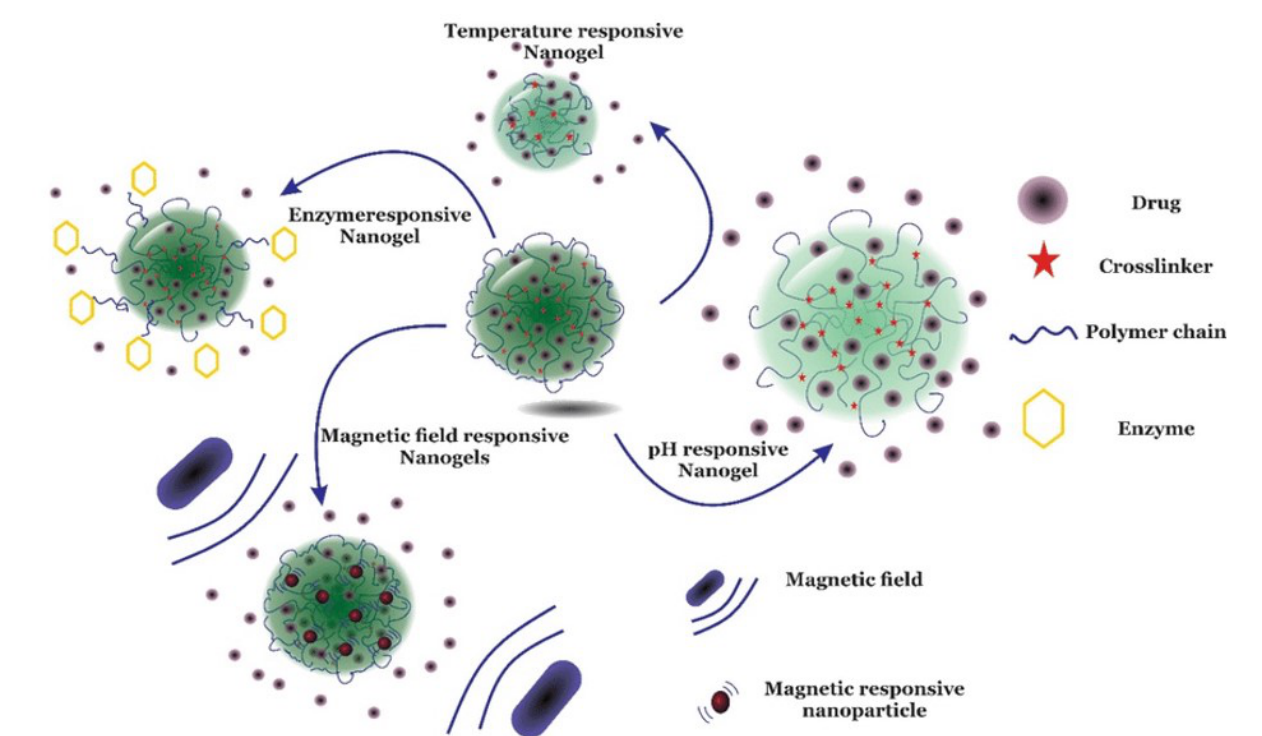
Figure 9. Schematic of drug release from nanogels in response to various stimuli [Obtained and reproduced without any changes from [183] and Gels MDPI in accordance with Creative Commons Attribution License (CC BY